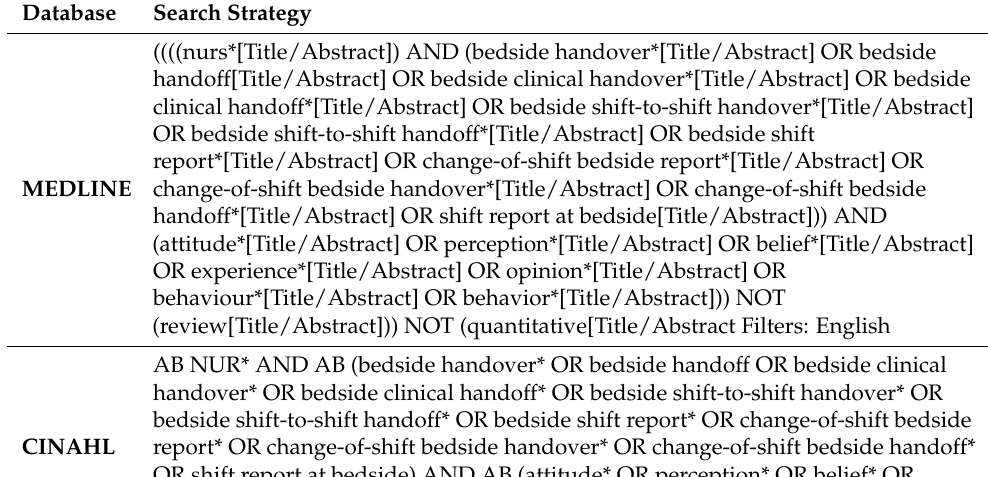
Table A1. Full search strategies for each